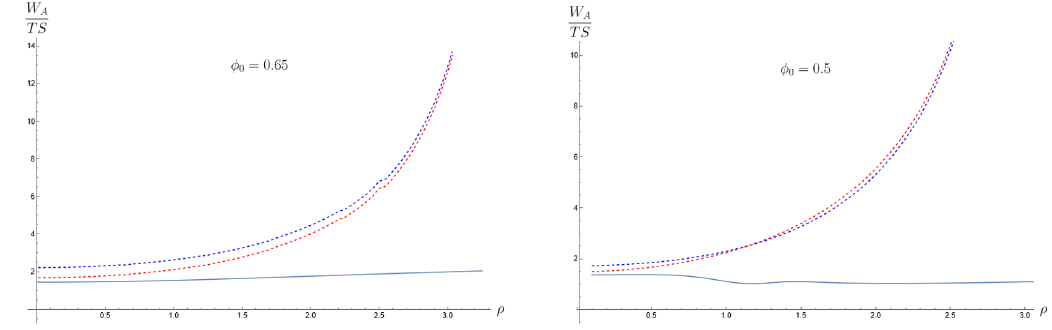
Figure 26 . In these pictures, we show W A / ( TS ) in solid line, (2 M D ) / ( TC ) in dashed blue line and (2 M N ) / ( TS ) in dashed red line (see eqs. (4.38) and (4.45)) as a function of ρ for a fixed φ 0 and z h = 1 . Left: neutral scalar. Right: charged q = 1